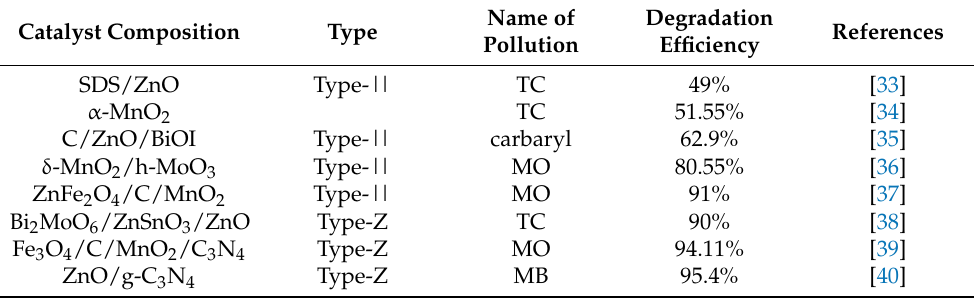
Table 1. The comparison of catalytic degradation related to ZnO and MnO 2